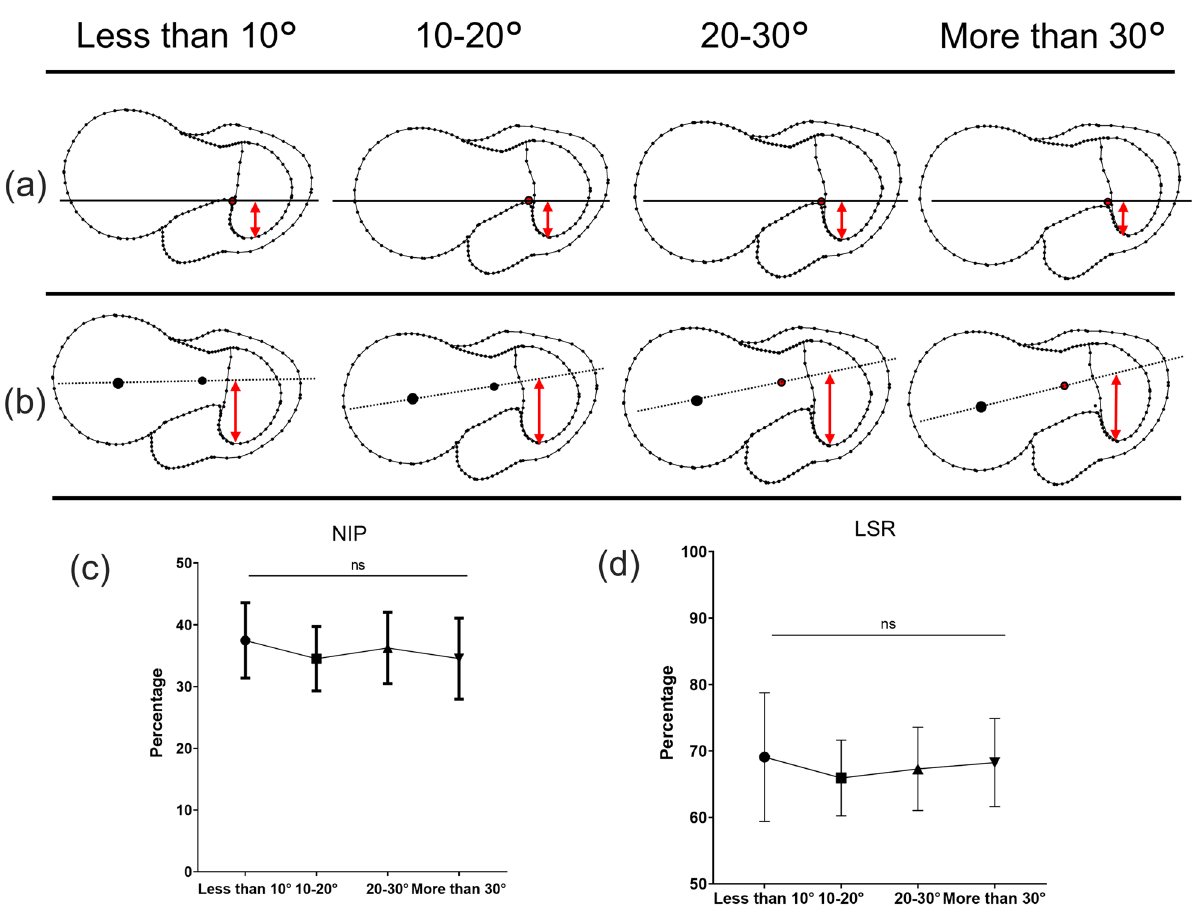
Figure 5. The shapes of the proximal femur according to the native anteversion, where ( a ) is the insertion point to the canal at the greater trochanter (NIP), and ( b ) is the intersection point of the head-neck axis and greater trochanter (LSR). ( c ) and ( d ) show the details and ANOVA results of NIP and LSR,